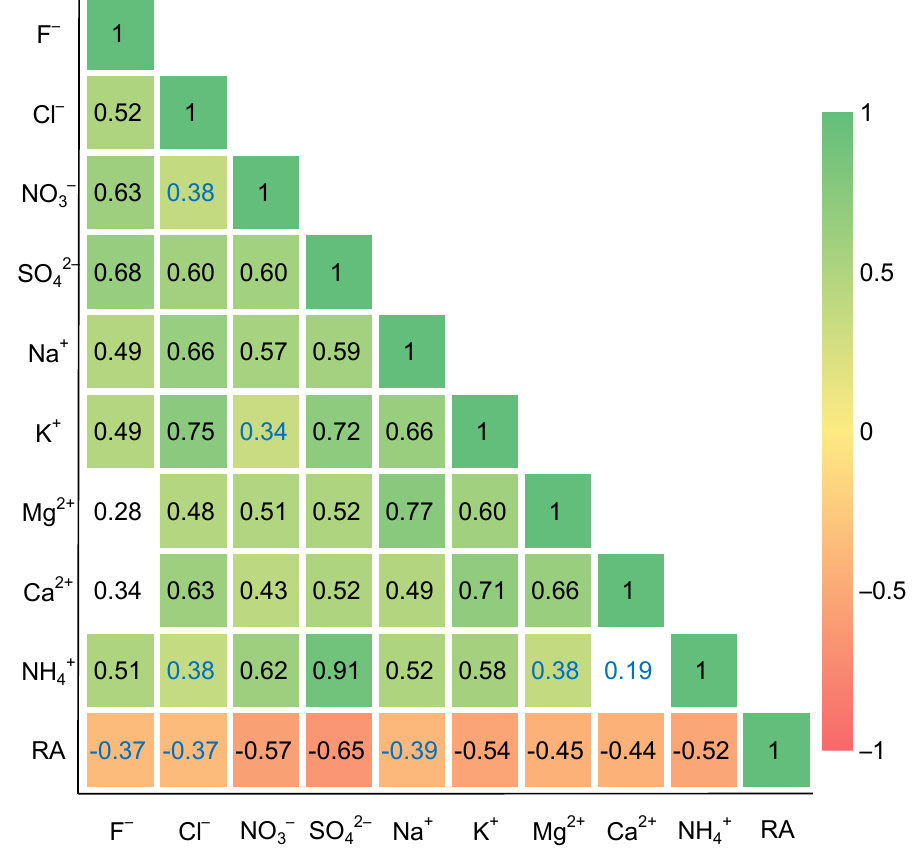
Figure 6. Spearman’s rank correlation coe ffi cients between monthly major ions in rainwater and RA; white cells denote statistically non-significant correlations ( p > 0.05), blue font cells denote the significance level of p < 0.05, and other cells denote the significance level of p <